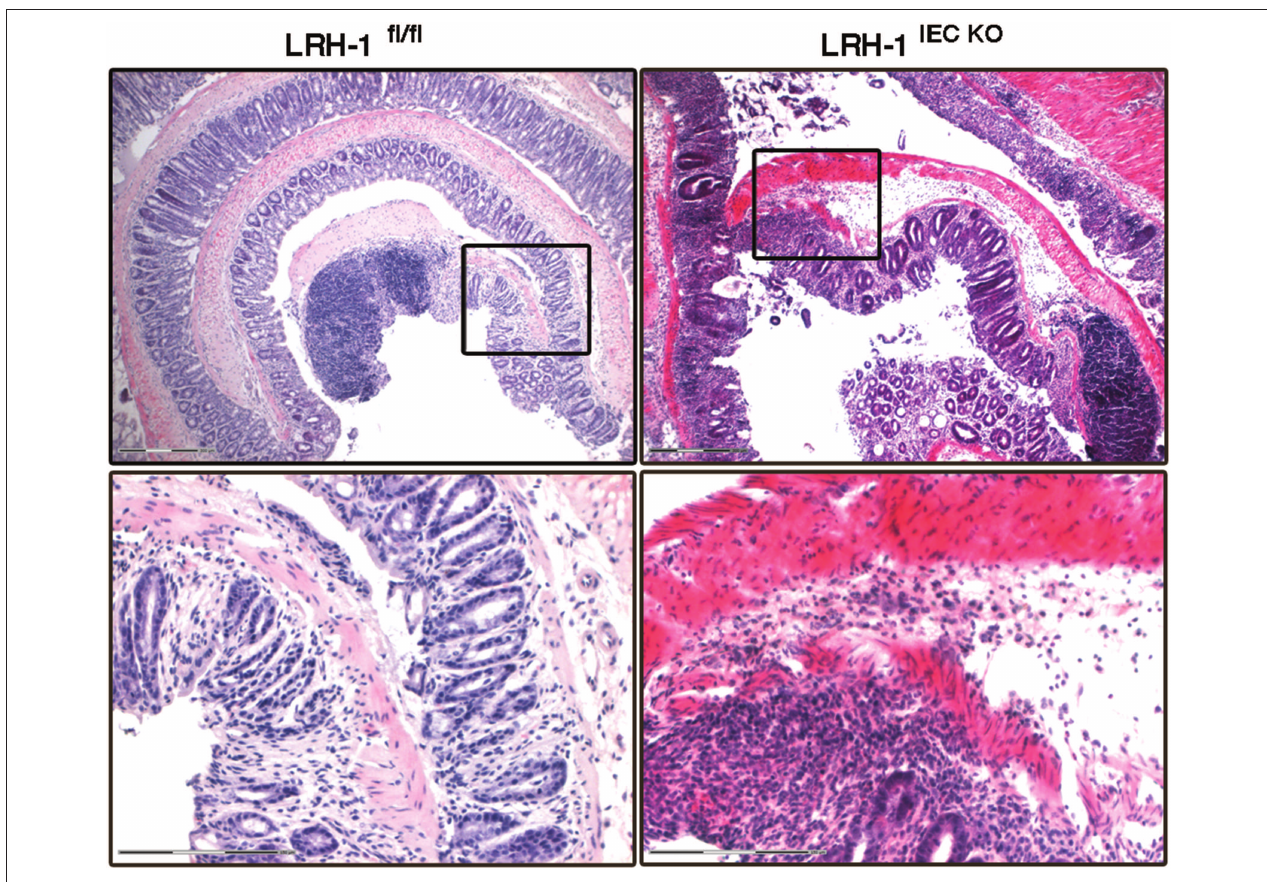
FIGURE 3 | LRH-1 is critical for intestinal immune homeostasis. Colitis was induced in female 8–9 weeks-old wild type (LRH-1 fl / fl ) mice and intestine epithelial cell-specific knockout mice (LRH-1 IEC KO ) by administration of 2.2% (w/v) DSS in the drinking water for 5 days followed by normal drinking water for 2 days. Representative H&E staining of Swiss-rolled colon sections of mice treated with DSS at day 7 showing the exacerbated colitis in LRH-1 IEC KO mice compared to LRH-1 fl / fl mice. Scale bars: 300 µ m overview, 150 µ m